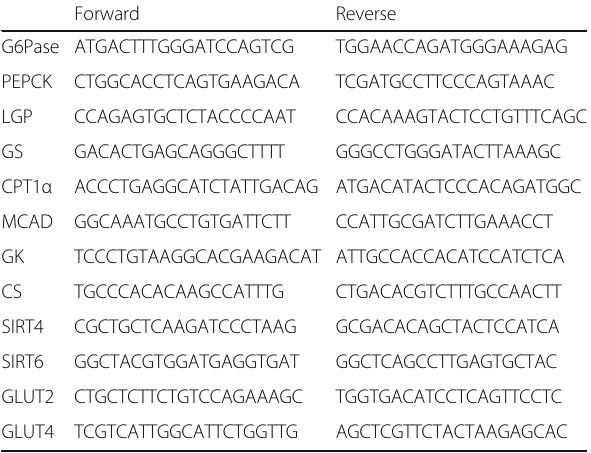
Table 1 Primers for quantitative real-time polymerase chain reaction analysis